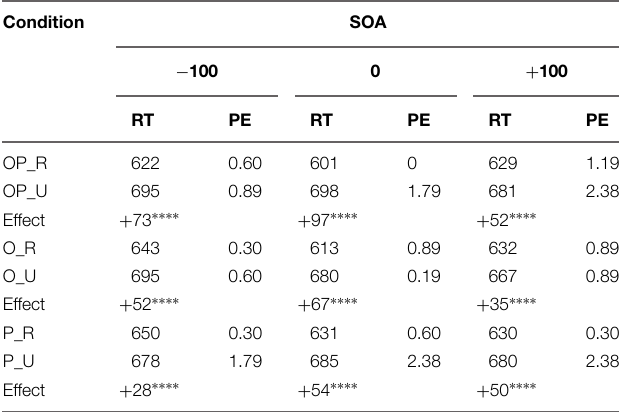
TABLE 5 | The mean latencies and error percentages for Relatedness, Distractor Type, and SOA in Experiment 3. Condition SOA